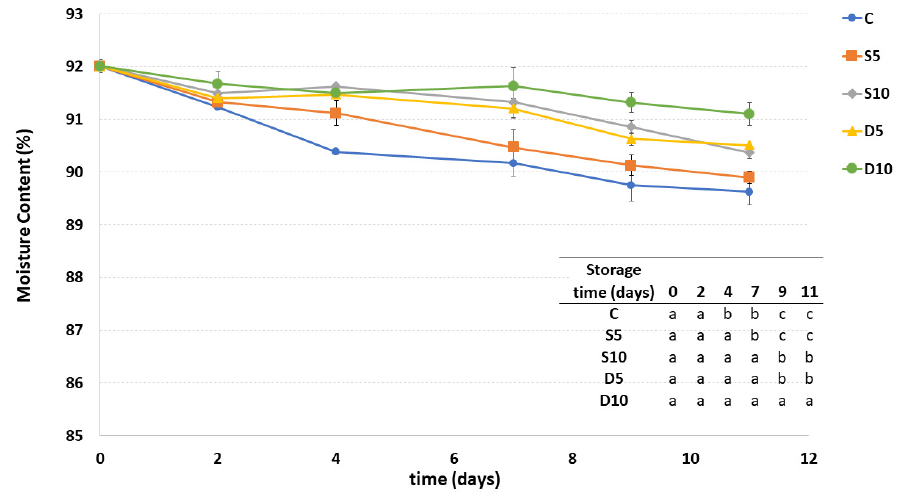
Figure 3. Moisture content of fresh-cut melon samples (C, D5, D10, S5 and S10) during storage. a–c Different letters in the same column indicate significant differences ( p < 0.05) between all considered samples at each storage time.